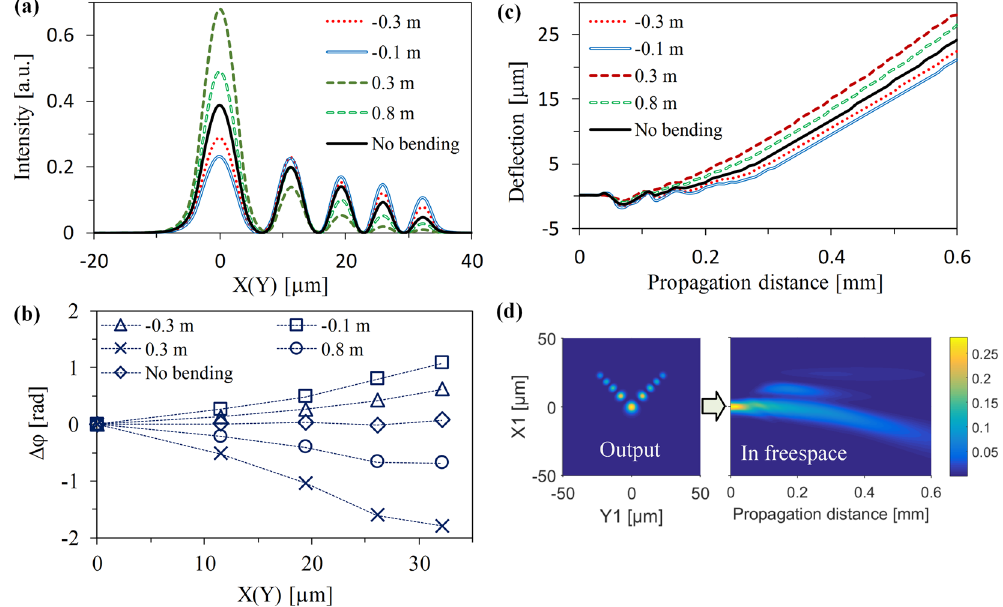
Figure 7. The characteristics of the output beam from the Airy fiber with different bending radius. ( a ) The intensity distributions. ( b ) The phase profiles at local intensity peaks. ( c ) Deflection of main lobes of the beams during propagation in free space. ( d ) Optical field distributions of the transverse output beam (left) and its longitudinal propagation beam (right) in free space when the bending radius of Airy fiber is –0.1